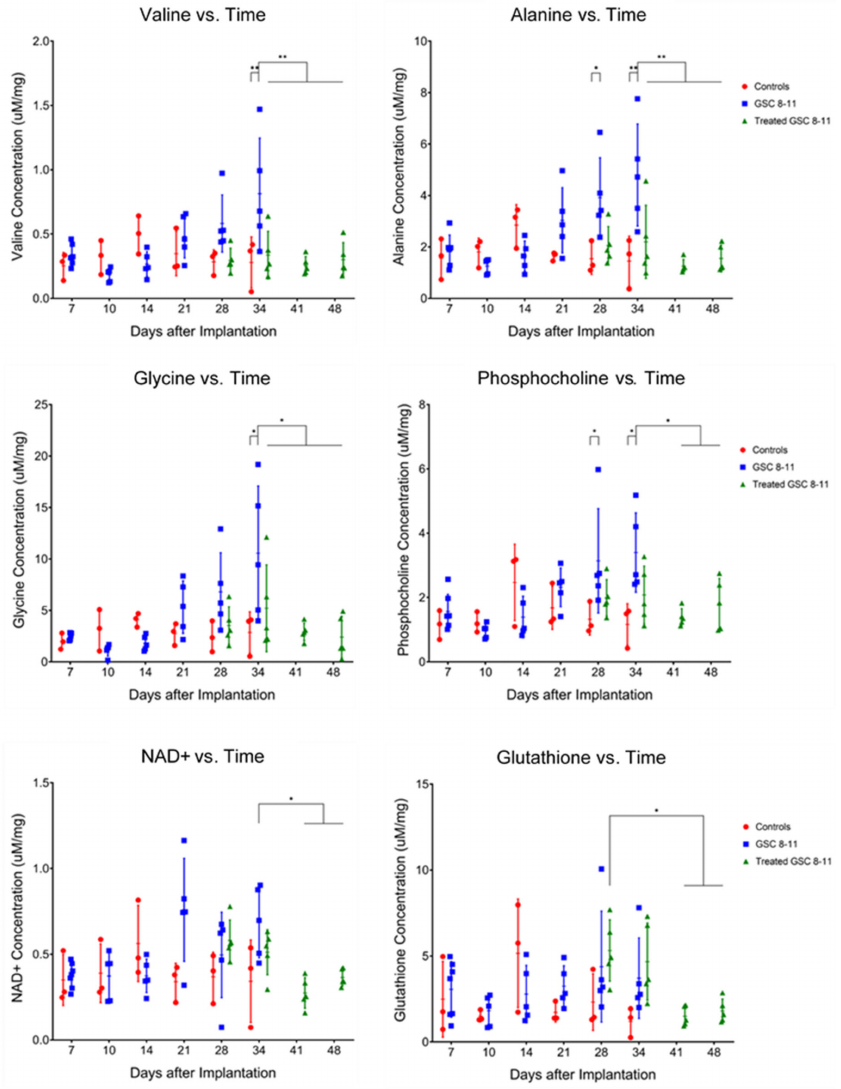
Figure 5. Ex vivo metabolite pool sizes are significantly altered throughout tumor development and regression. Individual metabolite pool sizes, measured with NMR spectroscopy, are plotted as a function of time for control mice (red circles) and untreated (blue squares) and treated (green triangles) tumor-bearing mice. Error bars represent standard deviation. The Y -axis is reported as concentration of metabolite pool per mg of tissue. Statistical significance was determined using ordinary one-way ANOVA and follow-up Fisher’s Least Significant Difference tests. The false discovery rate was controlled using the two-stage step-up method of Benjamini, Krieger and Yekutieli, and significance was attributed to comparisons that produced q < 0.05. * q < 0.05, ** q <